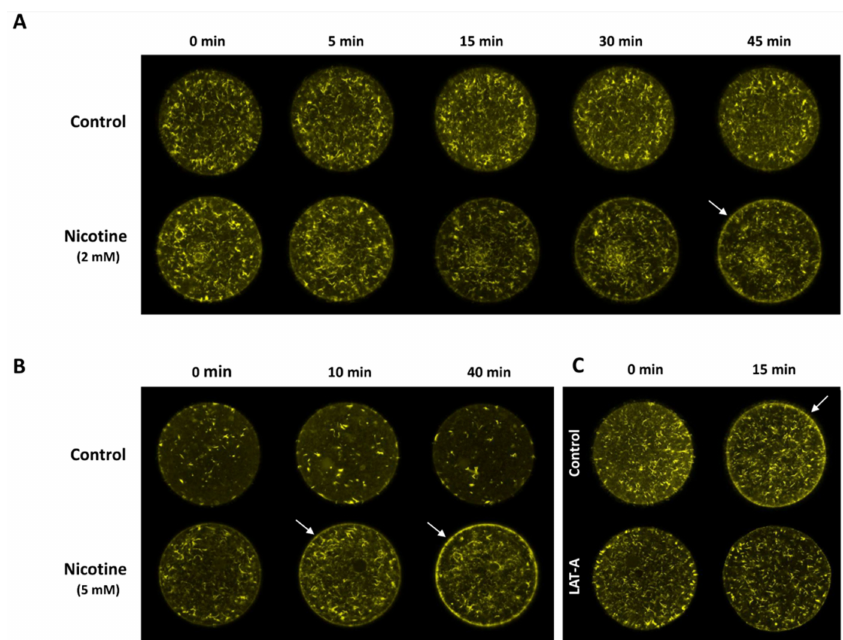
Figure 4. E ff ects of nicotine on the structure of the actin cytoskeleton in the subplasmalemmal region of sea urchin eggs. P. lividus eggs microinjected with AlexaFluor 568–phalloidin (10 µ M, pipette concentration) were incubated with di ff erent doses of nicotine, and the changes of F-actin were monitored on the equatorial plane of the live individual egg by confocal laser scanning microscope. ( A ) 2 mM nicotine, ( B ) 5 mM nicotine. The eggs from the same batch without nicotine exposure were used as the control. For each experiment, the moment immediately before nicotine or seawater addition was taken as t = 0. ( C ) Latrunculin A (LAT-A) attenuates nicotine-induced rearrangement of